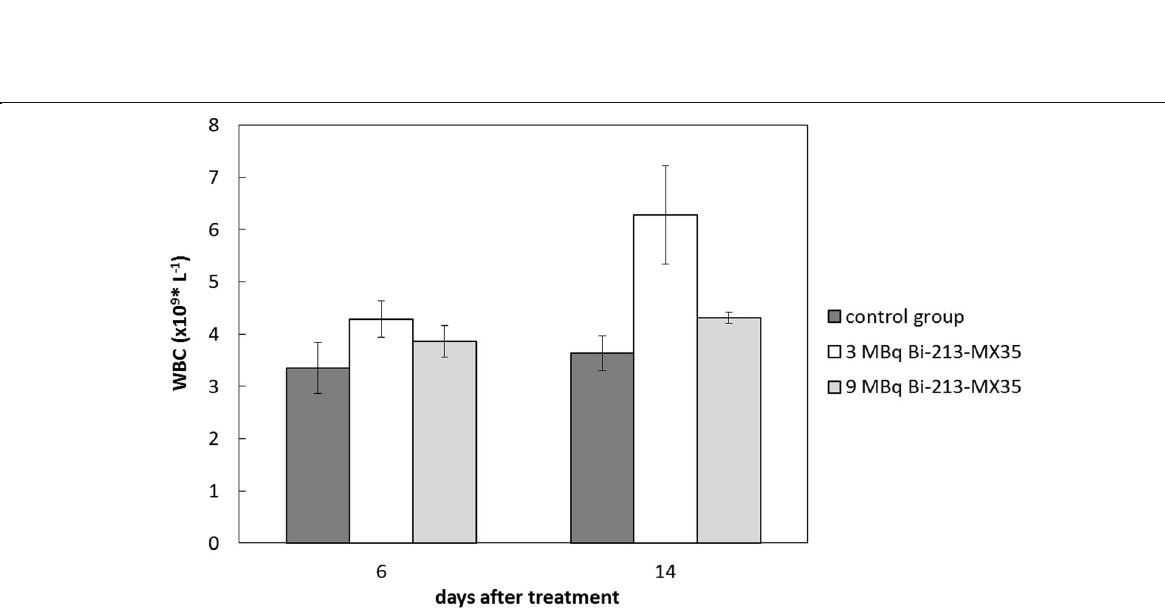
Fig. 2 White blood cell (WBC) counts measured in the blood samples taken from the tail vein 6 and 14 days after treatment. Each group consisted of five animals. Means and standard error of the mean (SEM; error bars ) are